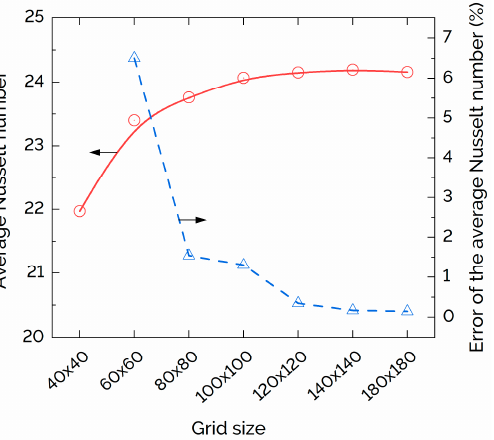
Figure 4. The convergence of Nu avg and its percentage of error for different mesh sizes.